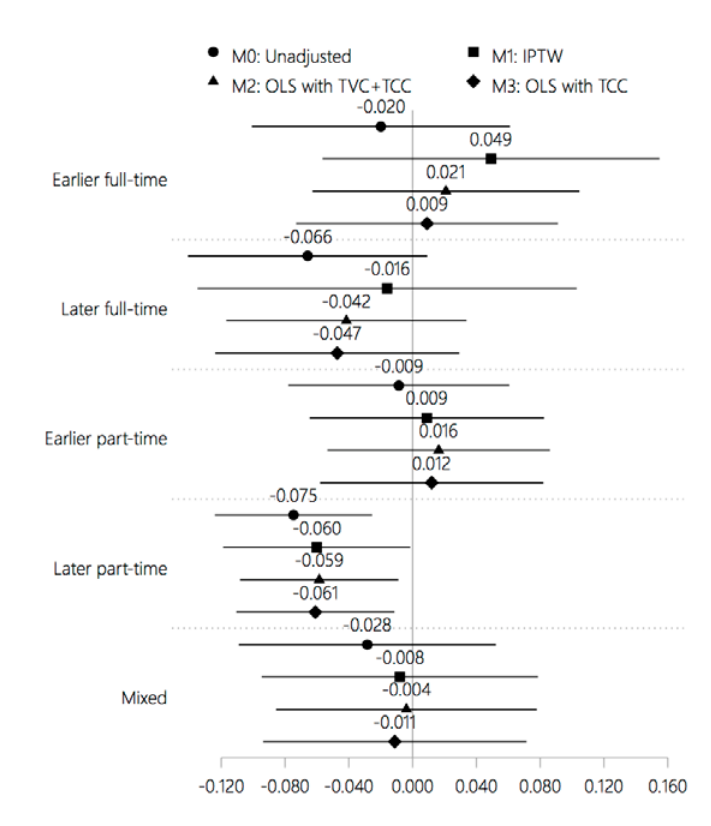
Figure 4 : Estimated difference in risk of child overweight around the age 6 between maternal employment patterns (ref: mostly not